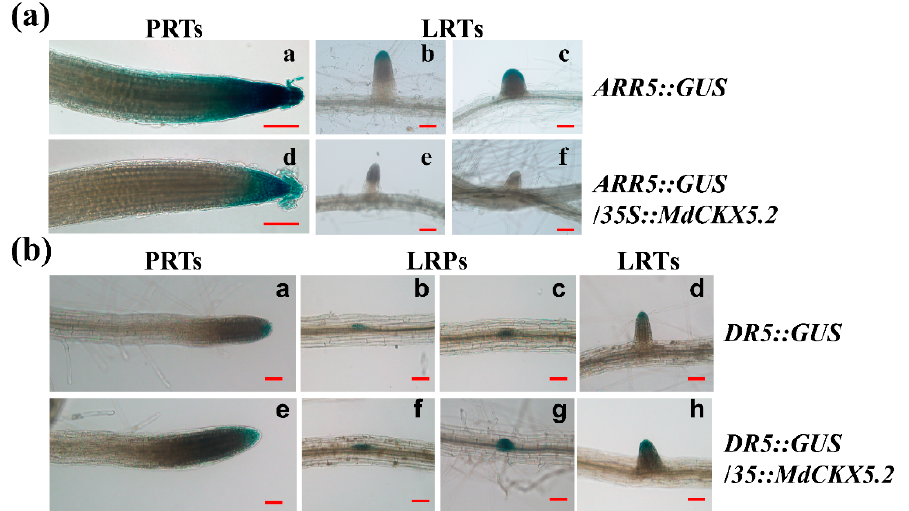
Figure 4. Effect of MdCKX5.2 on the redistribution of auxin and cytokinin in Arabidopsis root tips. ( a ) GUS staining of ARR5::GUS and ARR5::GUS / 35S::MdCKX5.2 in the primary root tips (PRTs) (a,d) and lateral root tips (LRTs) (b,c,e,f). ( b ) GUS staining of DR5::GUS and DR5::GUS / 35S::MdCKX5.2 in the primary root tips (PRTs) (a,e), lateral root primordiums (LRPs) (b,c,f,g), and lateral root tips (LRTs) (d,h). Six-day-old plants were used for staining. Bar = 0.5 mm.